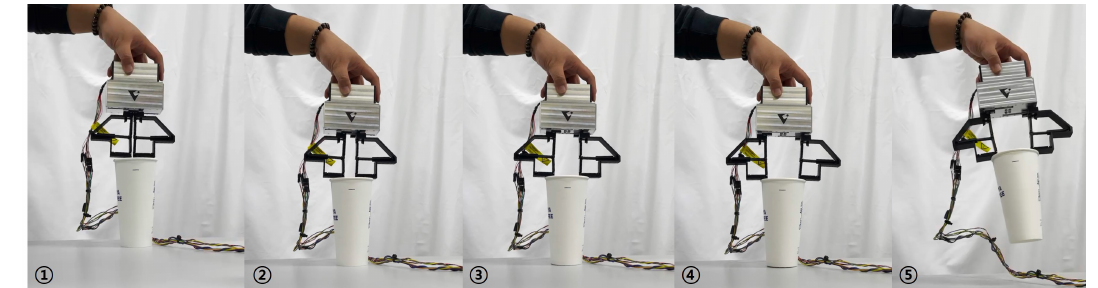
Figure 14. Sequential steps of spread grasp to hold an empty paper cup (Mass: 20 g, size: φ = 82 mm with length 160